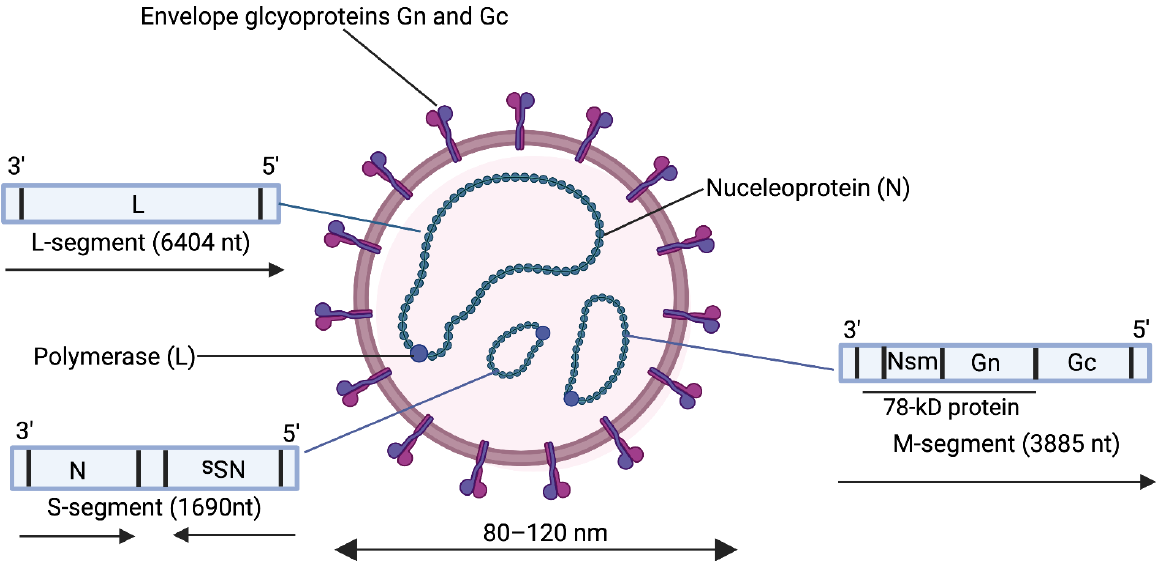
Figure 1. Structure and genomic organization of Rift Valley fever virus. Created with Bioren- der.com.